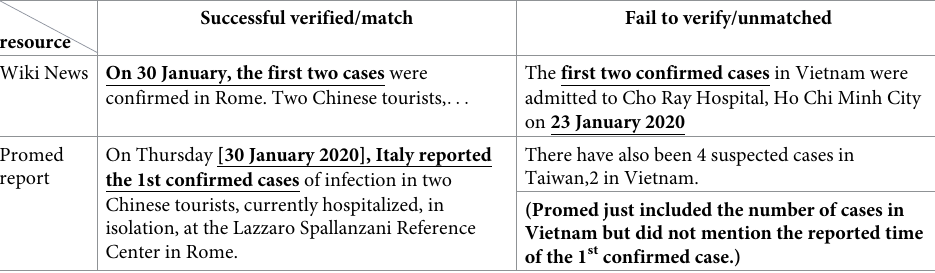
Table 2. Comparison table of Wiki news and Promed